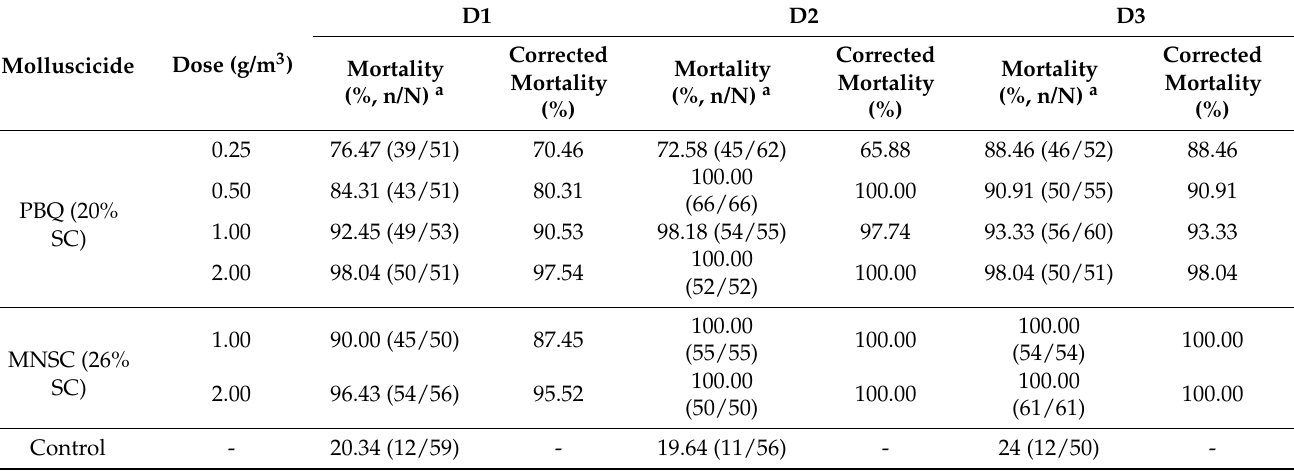
Table 2. Molluscicidal effect of different dosage forms of PBQ in ditch experiments.